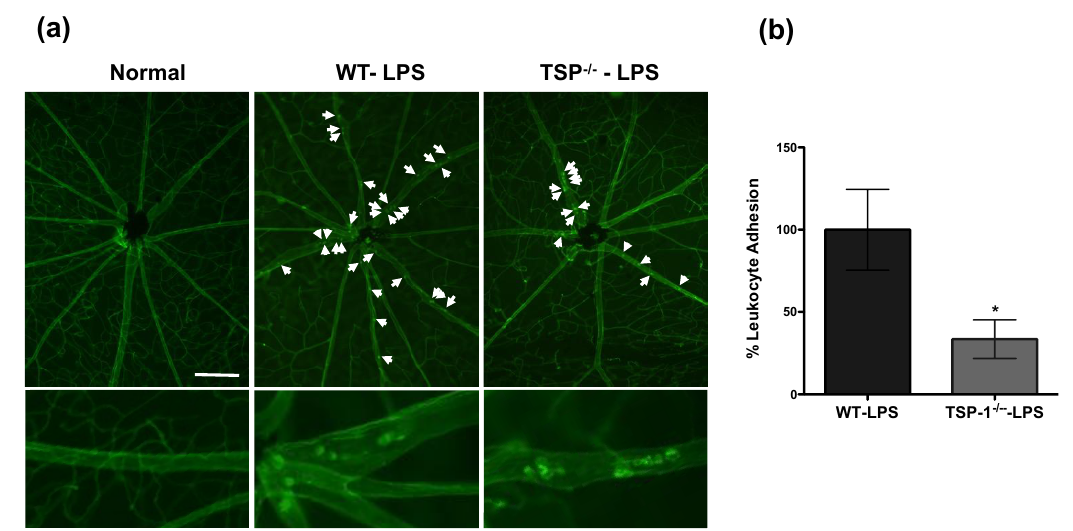
Figure 2. Expression of TSP-1 contributes to leukocyte adhesion to retinal vessels during LPS-induced acute uveitis inflammation in mice. Acute uveitis was induced in WT or TSP-1-deficient mice by administering 150 mg of LPS i.p. After 24 h, firmly adherent leukocytes in retinal vessels were visualized by perfusing the mice with rhodamine-conjugated ConA (red) before harvesting the retinas. ( a ) Representative images of retina whole mounts from untreated WT mice as normal and WT and TSP-1-deficient mice with EIU are marked with white arrows to indicate adherent leukocytes; ( b ) Quantitative assessment of adherent leukocytes in retinal vessels ( n = 3 – 4 each group). Data are expressed as leukocyte adhesion relative to mean number of adherent leukocytes in WT retina ± SEM. * p < 0.05. Scale bar = 200 µM.